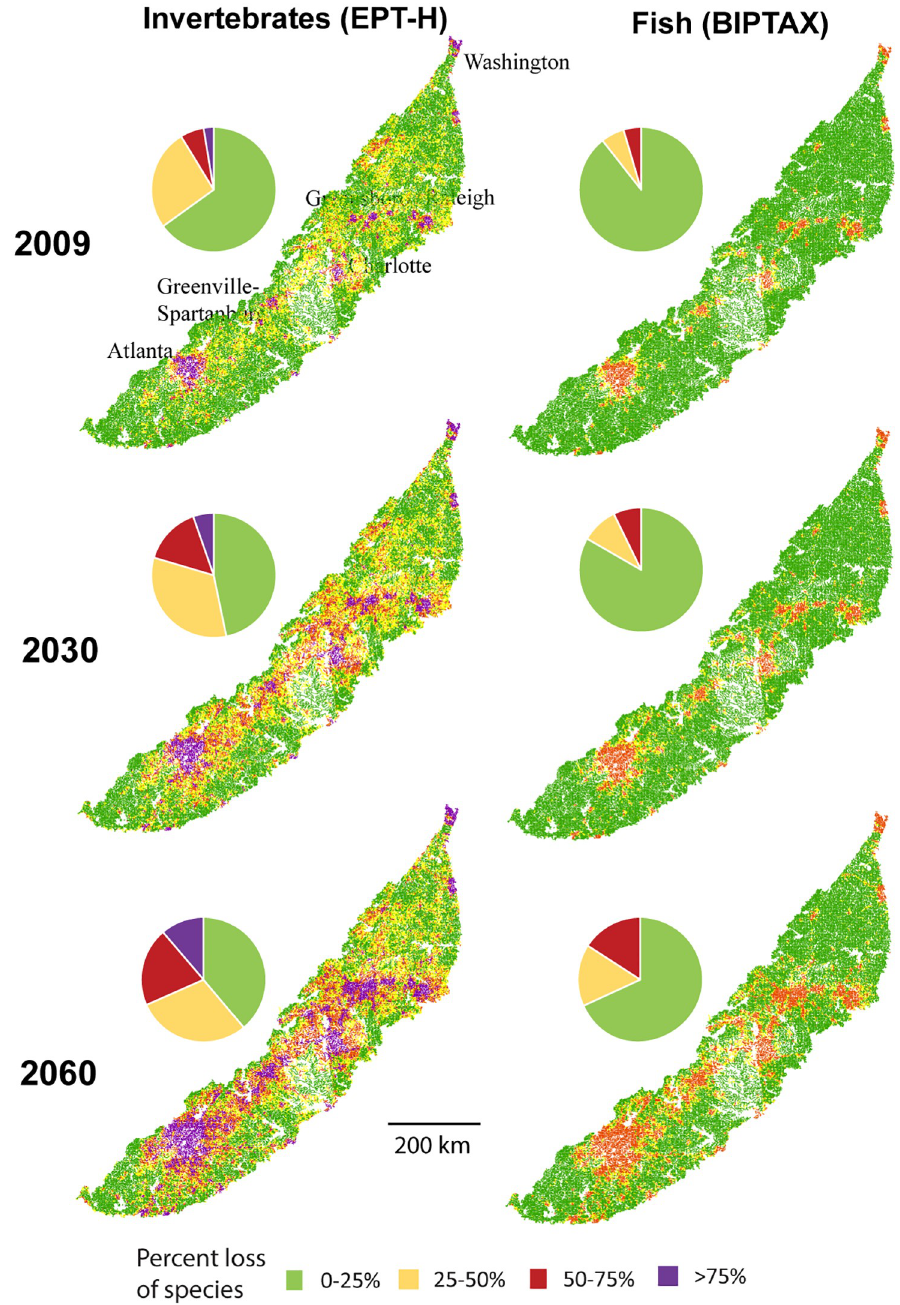
Fig 4. Modeled stream condition for the Piedmont ecoregion for 2009, 2030, and 2060 for number of sensitive invertebrate taxa (EPT-H) and benthic invertivore fish taxa (BIPTAX). Each map shows stream lines in the region colored by the loss of the ecological metric relative to undeveloped sites. Pies show the overall distribution of the metric by stream kilometers in each condition level. Major cities are labeled on the map in the upper left.